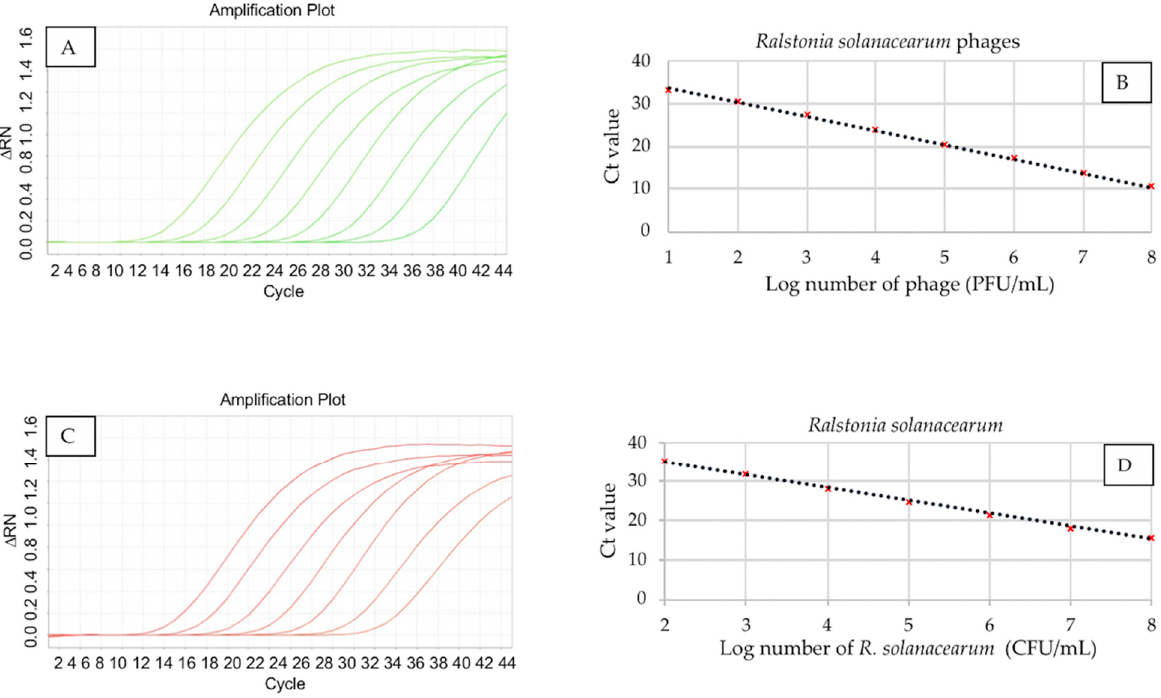
Figure 3. Quanti fi cation range of real-time duplex PCR. Ampli fi cation curves of 10-fold serial dilutions from 10 8 to 10 PFU/mL for vRsoP-WF2, vRsoP-WM2, and vRsoP-WR2 phages ( A ), and standard curve ( B ). Ampli fi cation curves of 10- fold serial dilutions from 10 8 to 10 2 CFU/mL for Ralstonia solanacearum ( C ), and standard curve ( D ). Standard curves were obtained with mean values of three replicates for each of the ten-fold serial